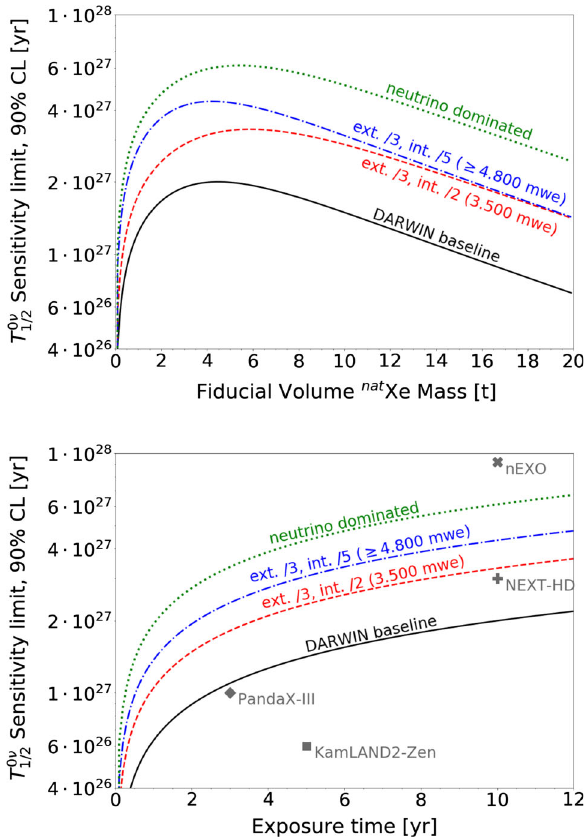
Fig. 8 DARWIN median T 0 ν sensitivity at 90% CL as a function of 1 / 2 fiducial volume mass for 10 years of exposure (top) as well as of the exposure time for the optimized fiducial volume (bottom). The base- line design is compared with different optimistic scenarios. The latter assume a reduction of the external (ext.) and the intrinsic (int.) back- grounds and improved spatial separation threshold of 10mm (red, blue) or 5mm (green). Sensitivity projections for future 136 Xe 0 νββ experi- ments are shown for comparison